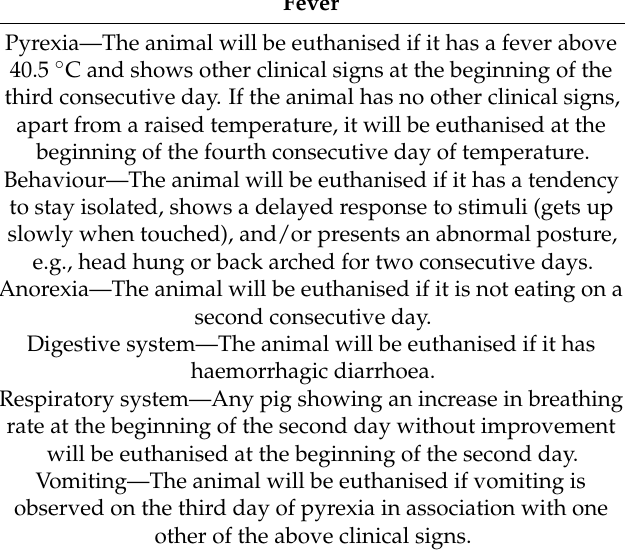
Table A1. Criteria for Humane End Points (set by the respective FMD and ASF studies). Humane End Points for Cattle Infected with Foot and Mouth Humane End Points for Pigs infected with African Swine Disease